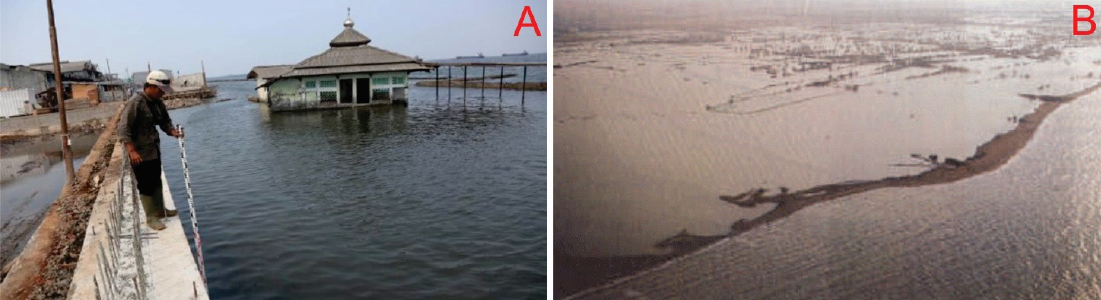
Figure 10. ( A ) Floods due to the land subsidence phenomena in Jakarta [183] , ( B ) Coastal flooding on April 2009 in Semarang [23] . April 2009 in Semarang [23].